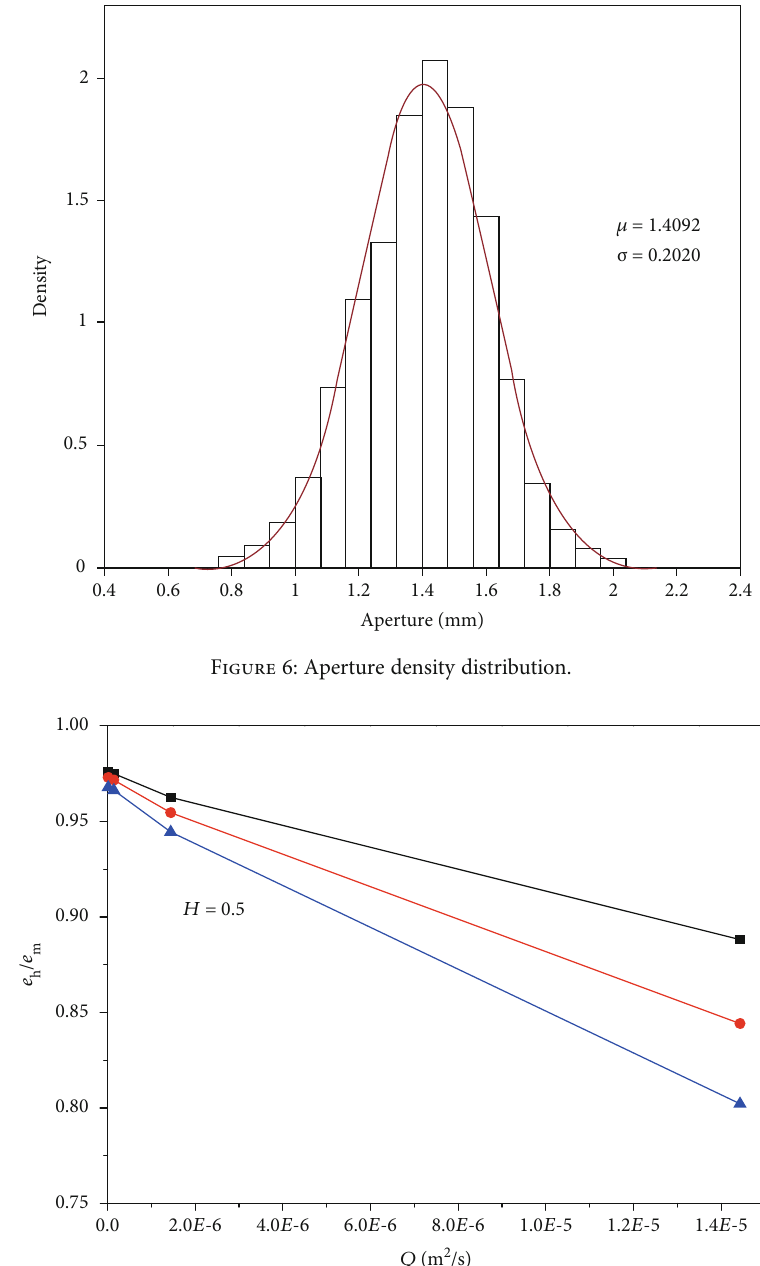
/ e varies with fl ow rate with H = 0 : 5 h m